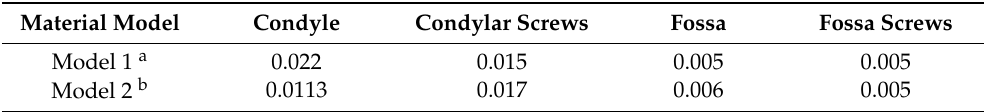
Table 4. Maximum deformation values in mm for two different materials model in customized TMJ